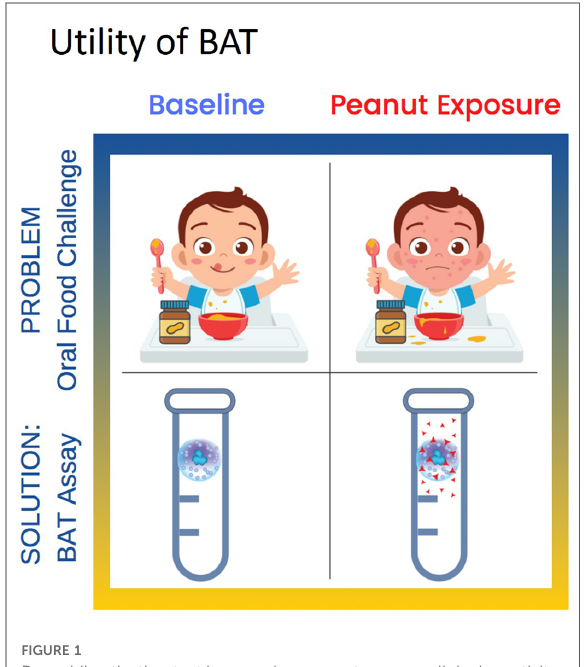
FIGURE 1 Basophil activation test is a good measure to assess clinical reactivity to prevent unnecessary food